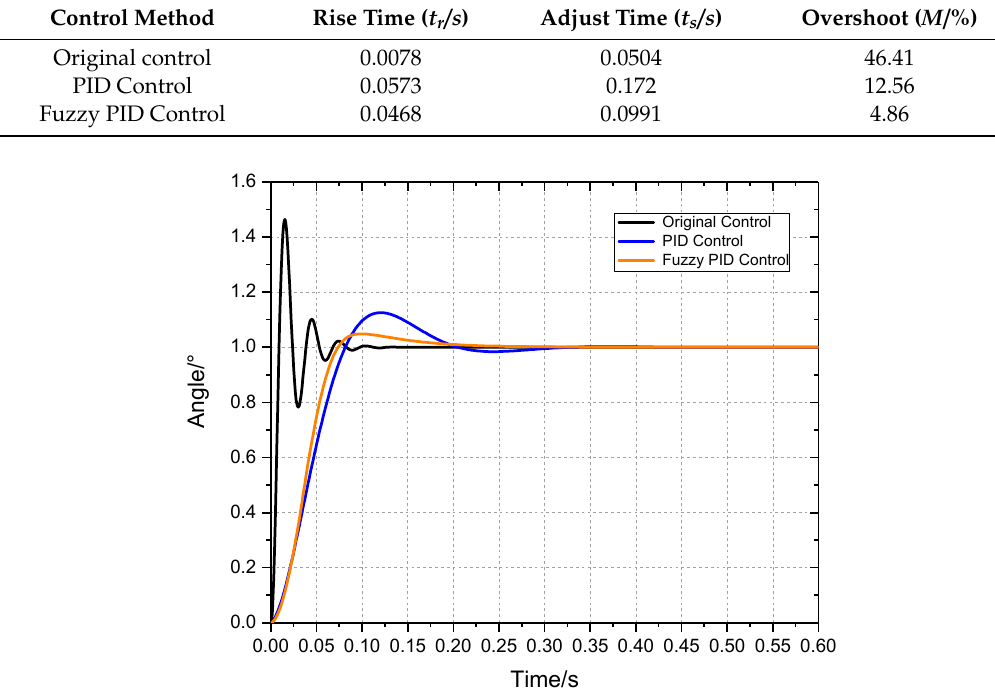
Figure 7. Fuzzy PID control Simulink simulation results.